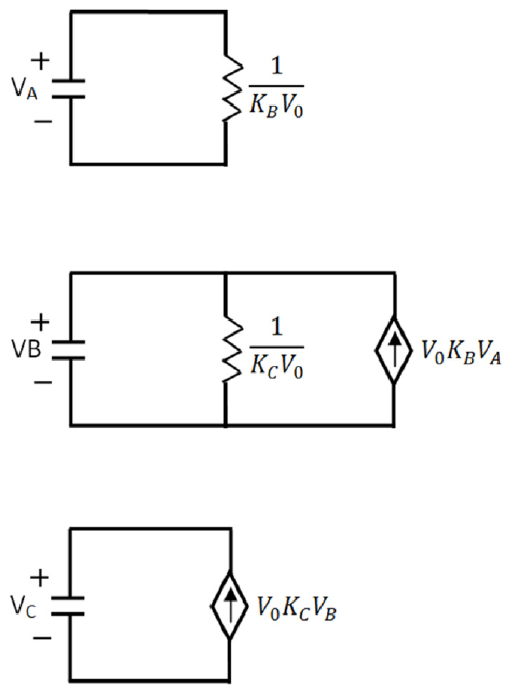
Figure 6. The analogous electrical circuit describing a triple consecutive reaction of concentrations [ A ], [ B ] and [ C ] used in the simulation software.